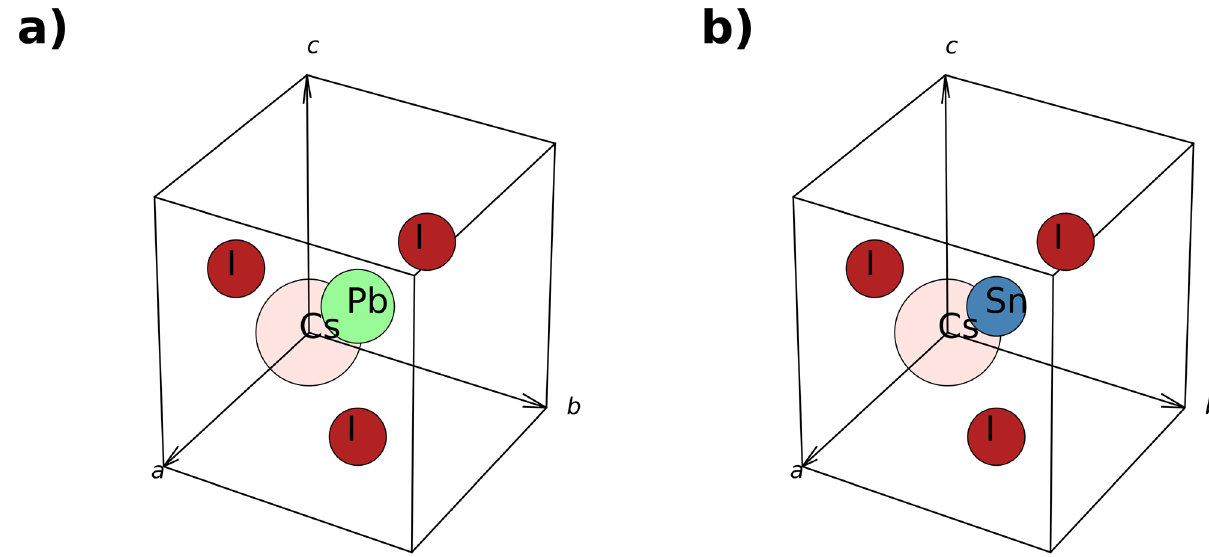
Fig. 7 Crystal structures of halide perovskites in cubic system. a crystal structure of CsPbI 3 . b crystal structure of CsSnI 3